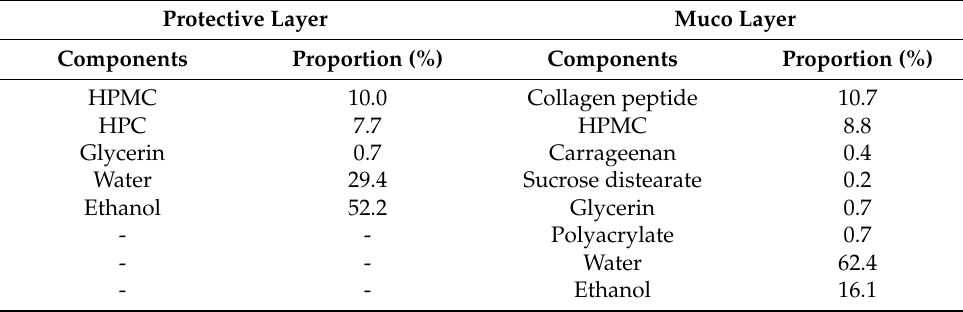
Table 1. Composition of the collagen peptide buccal delivery